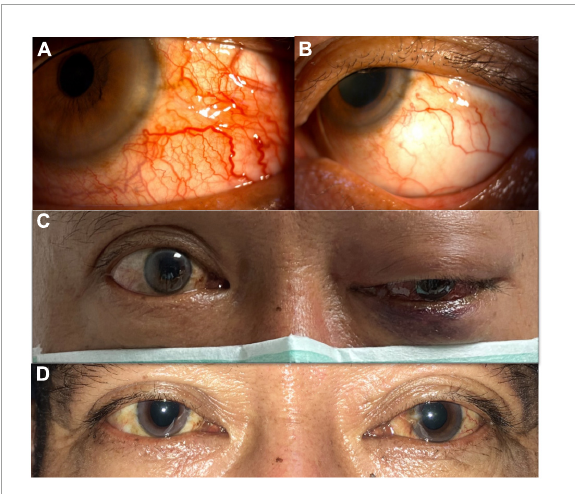
FIGURE7 (A) Before successful transarterial embolization (TAE). Severe congested conjunctiva with corkscrew vessels of the left eye. (B) After successful TAE. Congested conjunctiva improved and without corkscrew vessels. (C) Before successful TAE. Left eye ophthalmoplegia was observed. (D) After successful TAE. Left eye ophthalmoplegia improved.